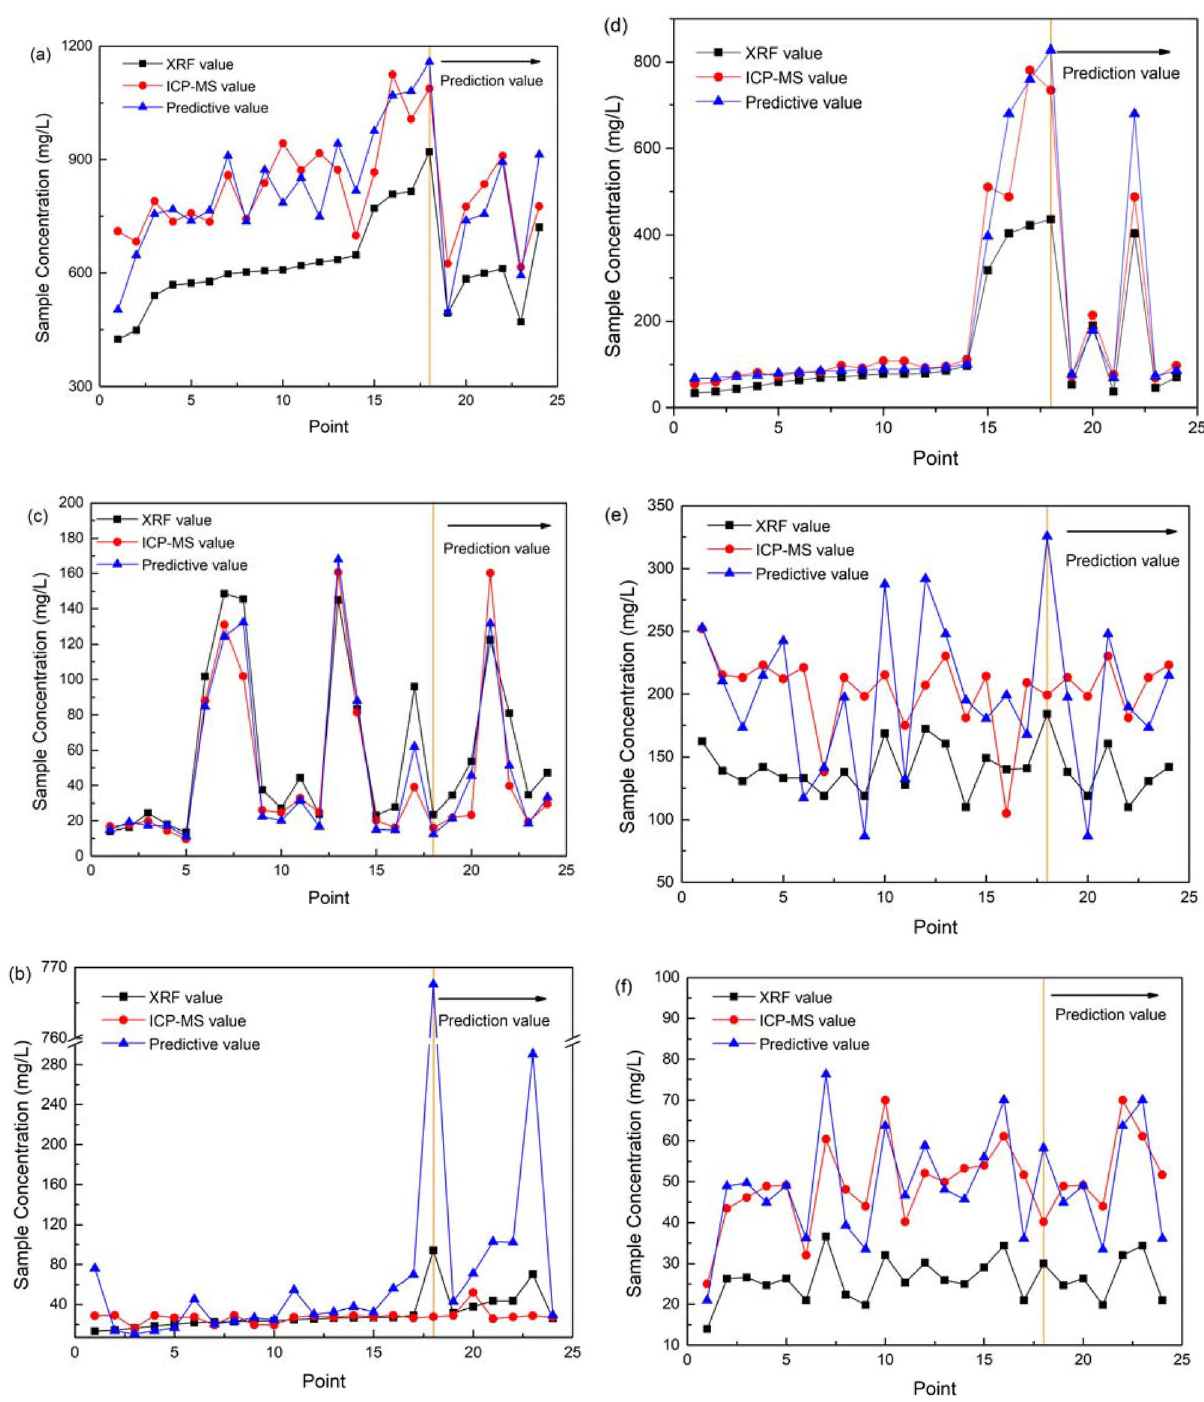
Figure 3. Comparison of model predicted value with original value ( a Mn, b Pb, c Cu, d Zn, e Sr, f